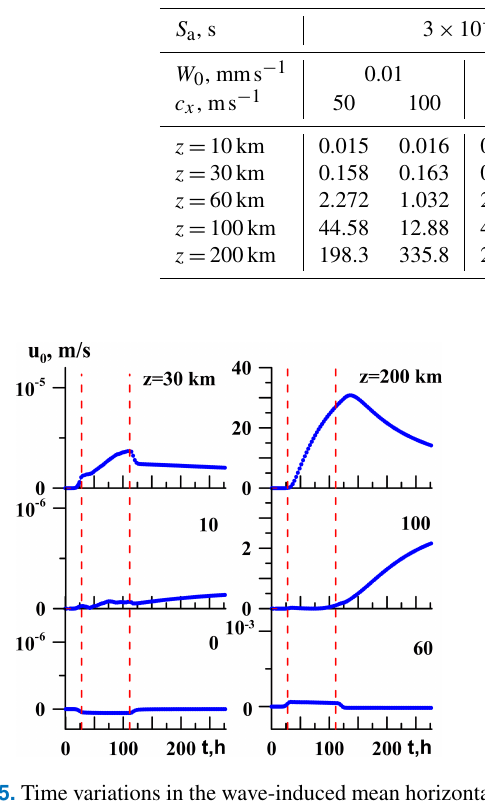
Figure 5. Time variations in the wave-induced mean horizontal ve- locity at different altitudes (marked with numbers) for the steep ac- tivations and deactivations of the surface wave source (Eq. 5) at c x = 100ms − 1 and W 0 = 0.1mms − 1 . Dashed lines correspond to t = t a and t = t d in (Eq.